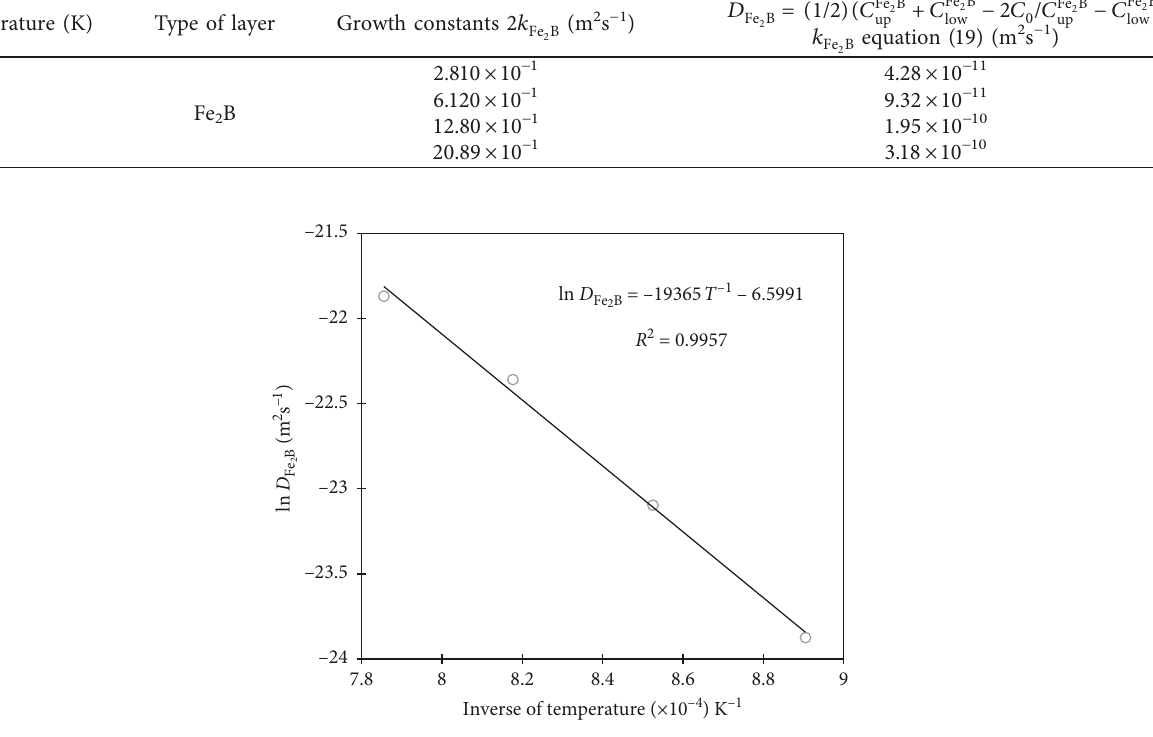
) from the first approach in the Fe 2 B layer. Fe 2 B 2 B layer using the second approach (non-steady-state diffusion model).